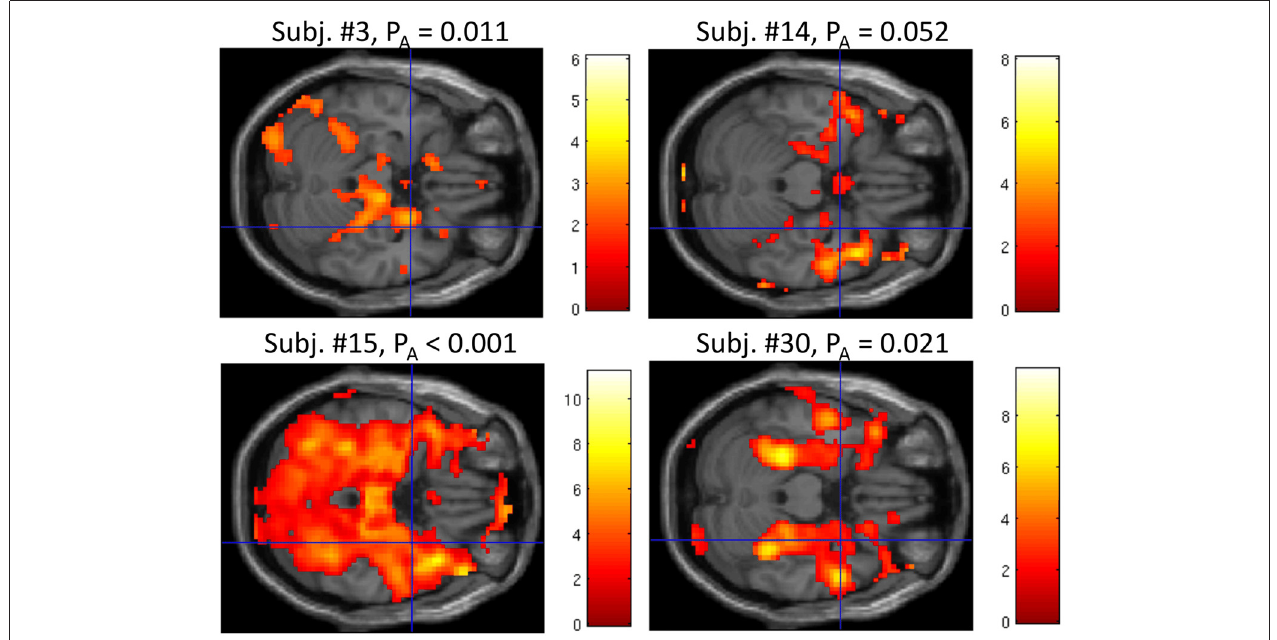
FIGURE 5 | Whole brain analysis of the contrast “UP” vs. “DOWN” regulation at P < 0.05 uncor. for the four “best” regulators based on the median P -values within the amygdala P A . The blue crosshairs mark the same position as in Figure 4 in the right amygdala (MNI coordinate [30, 2, − 23]). The scale represents t -values ( df = 280). While the activation in subjects 3, 14, and 30 does not appear to be driven by motion or physiology, in subject 15, it may be related to alterations of breathing, which could have induced a widespread increase of the BOLD